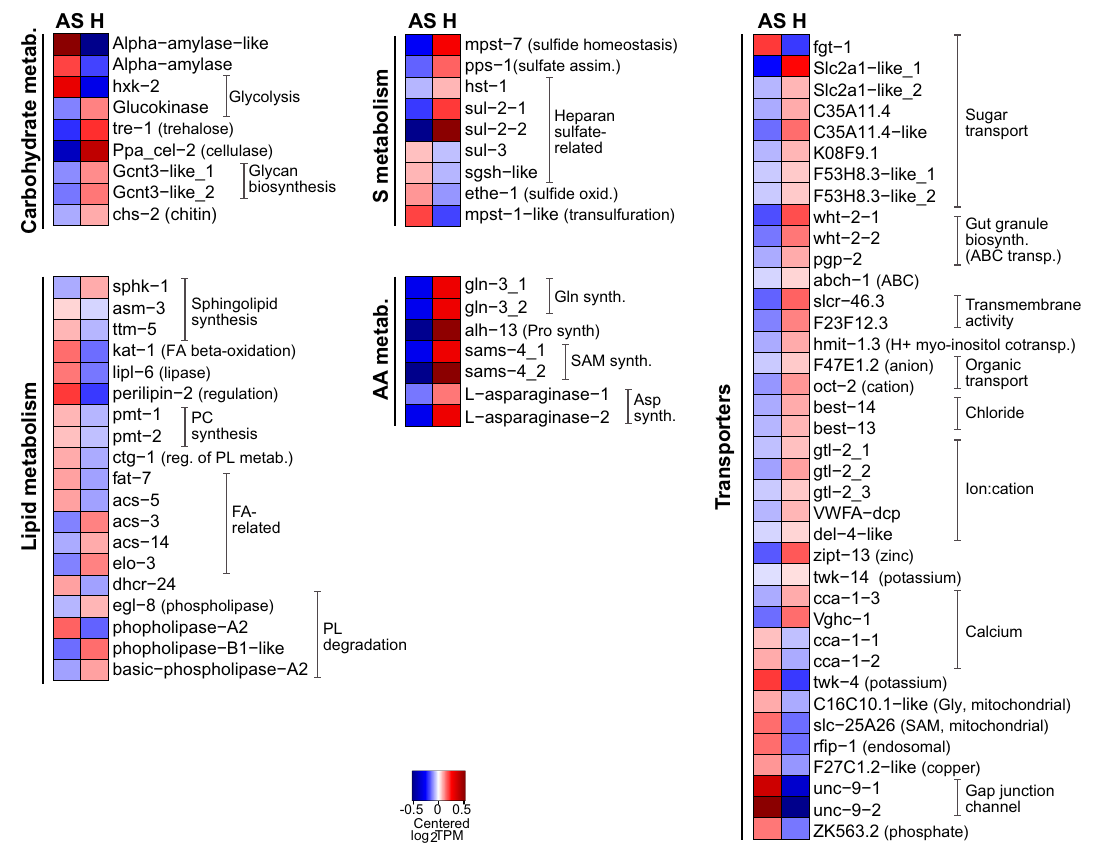
Figure 6. Genes involved in carbohydrate, lipid- and sulfur-metabolism, amino acids biosynthesis, and transport were predominantly expressed in hypoxic (H) worms. Heatmap displaying genes upregulated in H relative to AS worms, upon 24 h-long incubations under one of the two conditions (1.5-fold change, FDR ≤ 0.05). Expression levels are displayed as mean-centered log 2 TPM values (transcripts per kilobase million). Genes are ordered by function in their respective metabolic pathways. For each process, the minority of genes that were upregulated in AS worms is shown in Data S1. Red denotes upregulation, and blue downregulation. FA, fatty acids; PC phosphatidylcholine; PL, phospholipids; metab: metabolism; synth: synthesis; assim: assimilation, oxid: oxidation; Transp: